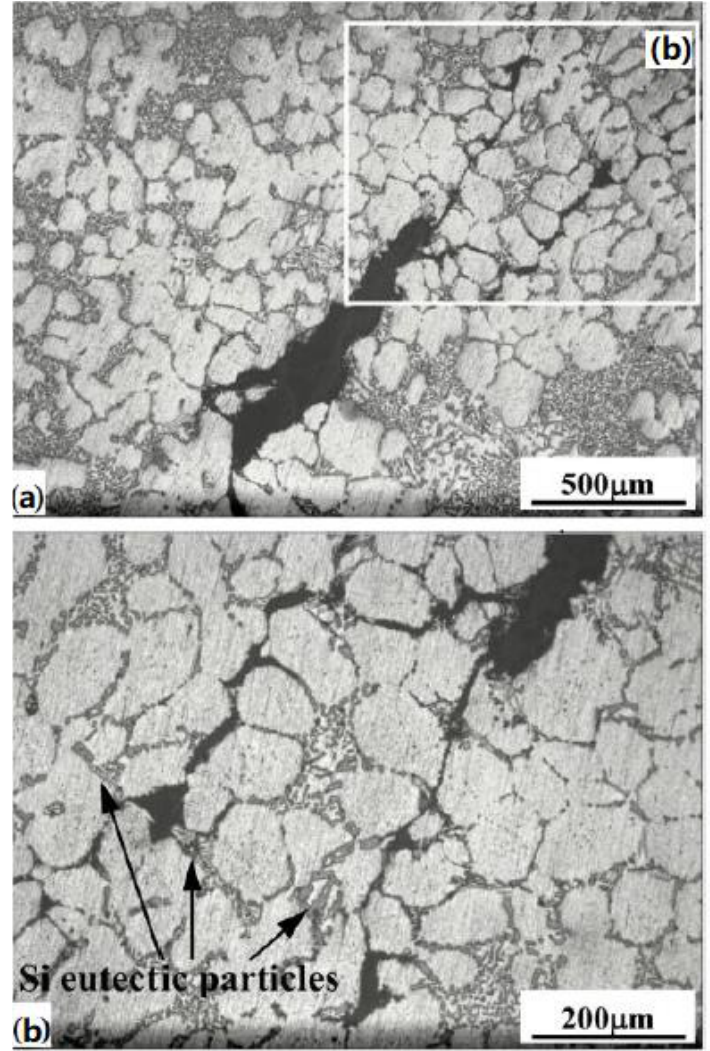
Figure 15. Bifilm (part of which is opened as a pore, while other parts remain closed as cracks) extending into the aluminium matrix found near the failed region of an Al-7%Si-Mg airframe casting. ( a ) the overall defect, ( b ) the magnified version of the square in ( a ) showing the unopened bifilms associated with the pore. Reprinted with permission from ref. [57]. Copyright 2022 Elsevier.